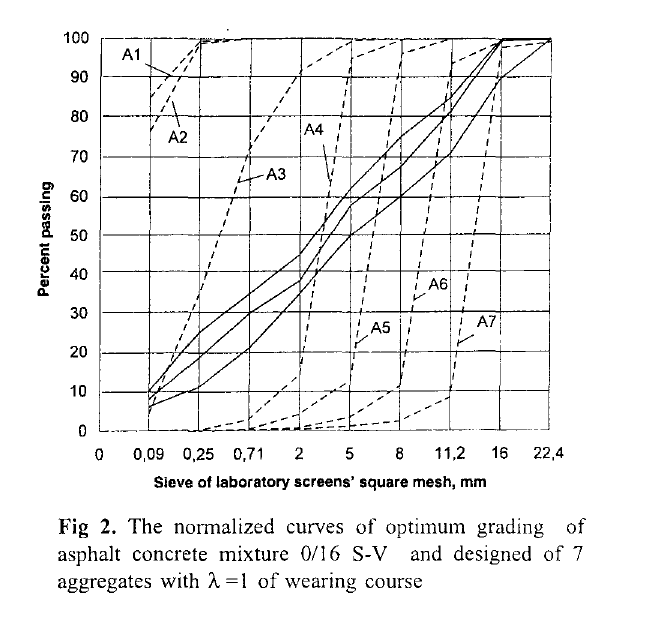
Fig 2. The normalized curves of optimum grading of asphalt concrete mixture 0116 S-V and designed of 7 aggregates with f... =I of wearing course Work Instructions. Beside mass of continuous hatchers which deliver flows and yields of initial cold aggregates, mass of finally batched hot fractions screened through technological screens, cold imported fillers and reclaimed dust portions measured by discrete hatchers shall be es timated with reference to the actual grading of these aggregates. Since the grading of aggregates changes, its mass shall be changed as well. It is rational to estimate the best quantities of all aggregates mass by applying conditional optimization mathematical model presented in the work which takes into consideration ratio of phalt concrete mixture production